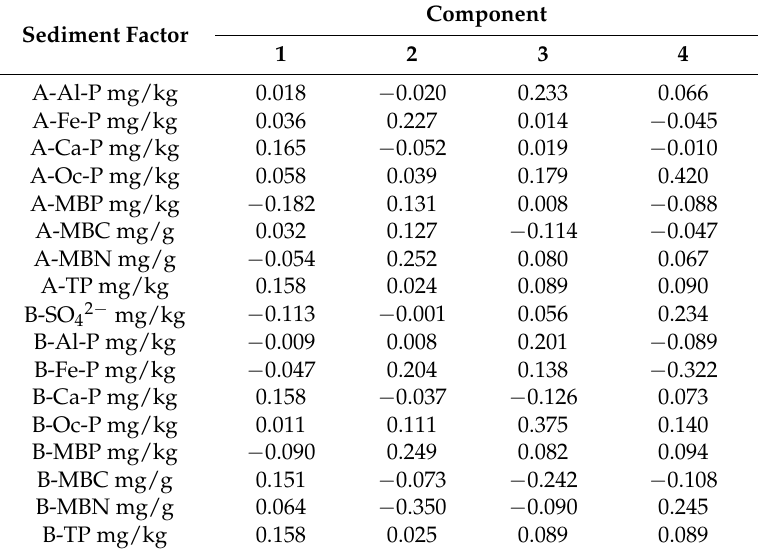
Table 5. Component score coefficient matrix of factors affecting phosphorus release rates of the sediment.